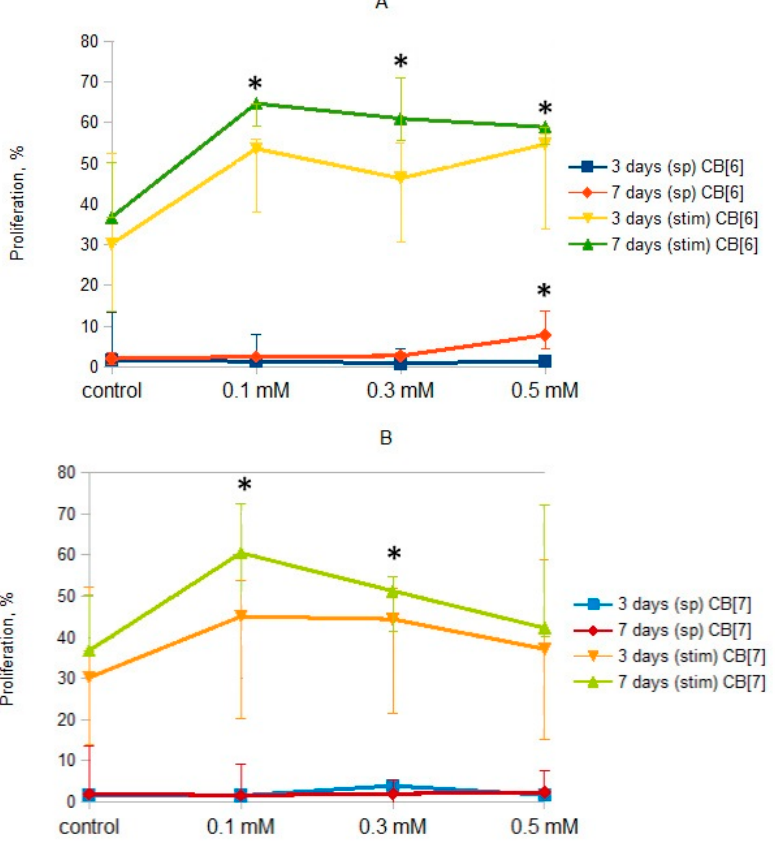
Figure 2. E ff ect of CB[n] on the relative number of proliferating T cells. ( A ): E ff ect of CB[6] on the relative number of proliferating T cells. ( B ): E ff ect of CB[7] on the relative number of proliferating T cells. Data are presented as the median with interquartile range. (* Indicates a significant di ff erence ( p < 0.05) vs. the control. (sp)—Spontaneous proliferation; (stim)—Anti-CD3-stimulated proliferation.